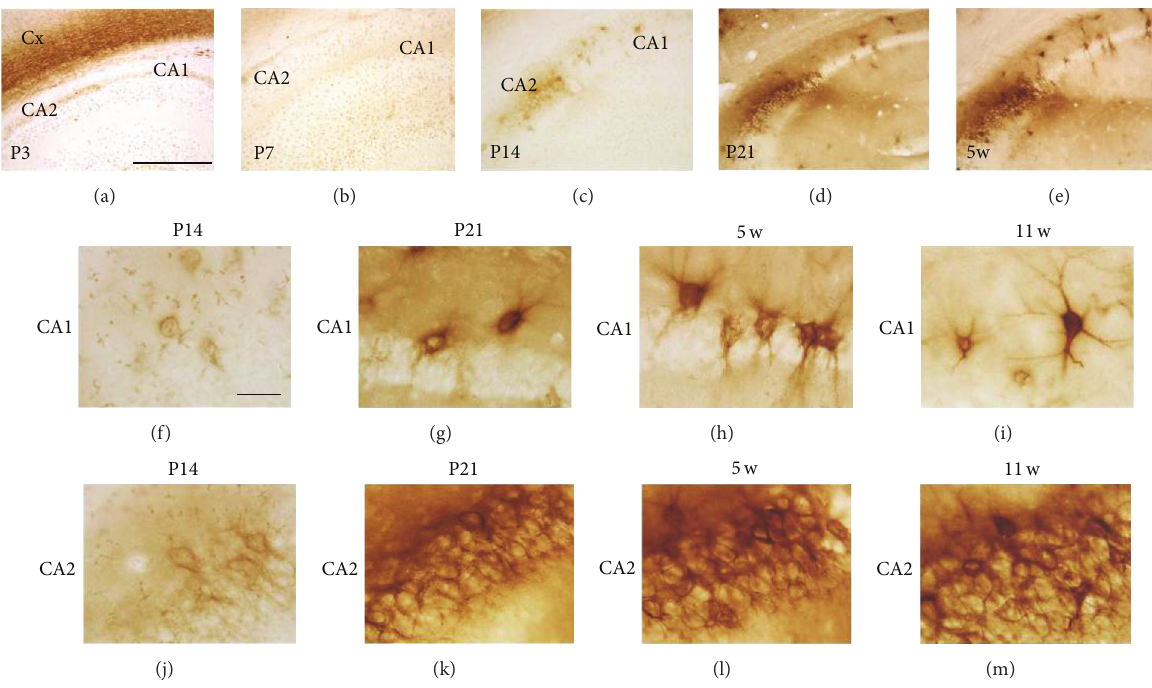
Figure 2: WFA-stained ECM in the developing hippocampus. (a–e) WFA-labeled images at P3 (a), P7 (B), P14 (c), P21 (d), and 5w (e). PNN- like WFA reactivity was observed from P14 onward. (f–m) Higher magnification images of the CA1 (f–i) and CA2 (j–m) at P14 (f, j), P21 (g, k), 5w (h, l), and 11w (i, m). Diffuse PNN-like staining was observed in the CA1 at P14, which gradually surrounded cell bodies and dendrites from P21 onward. WFA reactivity in the CA2 from P21 onward was strong and showed a complex staining manner. Cx: cerebral cortex. Scale bars = 500 (a–e) and 50 (f–m) 𝜇